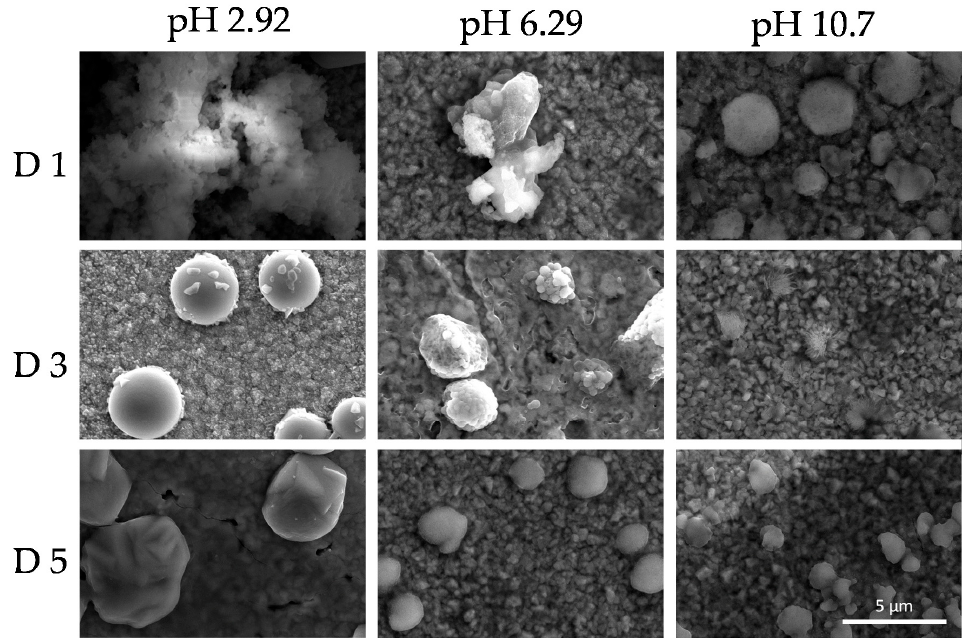
Figure 10. Scanning electron microscopy (SEM) micrographs at a magnification ×15,000 of the colloids (PKHEDA 1 × 10 ⁻ 4 M/TPPS 5 × 10 − 5 ) at three different pH (2.92, 6.29, and 10.70) during five days (day 1 = D1, day 3 = D3, day 5 = D5).